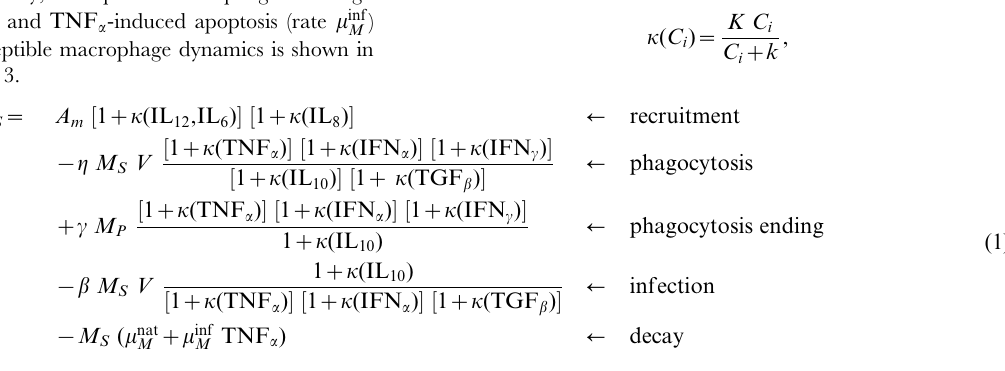
cytokines and inhibited by IL 10 (2a in Figure 1). Activated